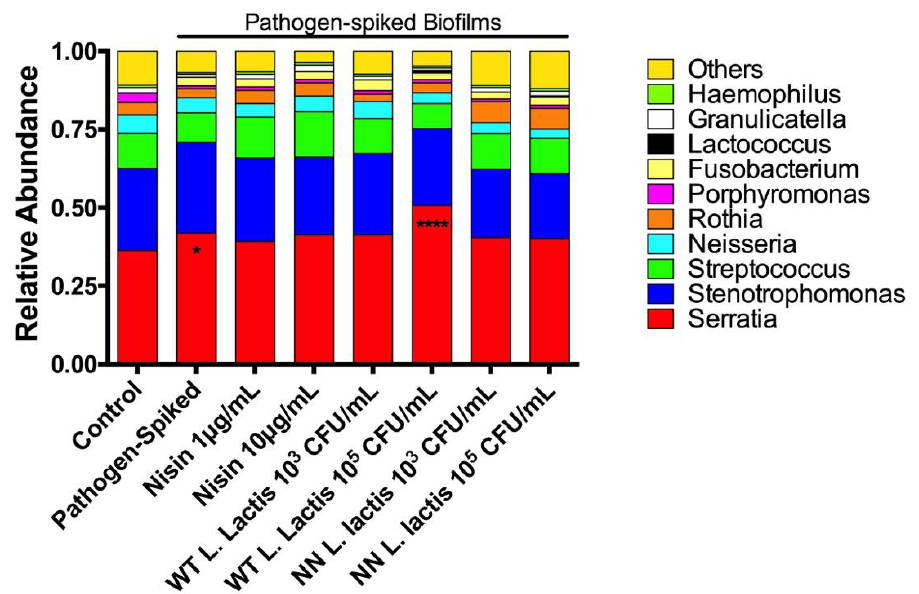
Figure 6. Lower doses of nisin and probiotic revert the Serratia genus back to control levels. Top 10 genera relative abundance are displayed; * means p ≤ 0.05; while **** means p ≤ 0.0001 between the marked sample and